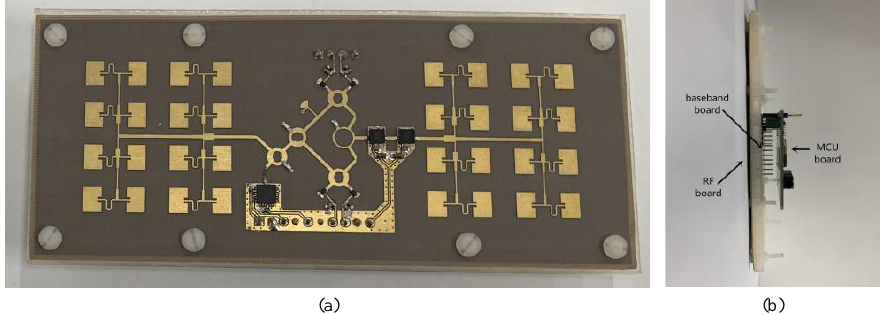
Figure 6. Photographs of the 24 GHz auditory radar from ( a ) front side and ( b ) right-hand side.